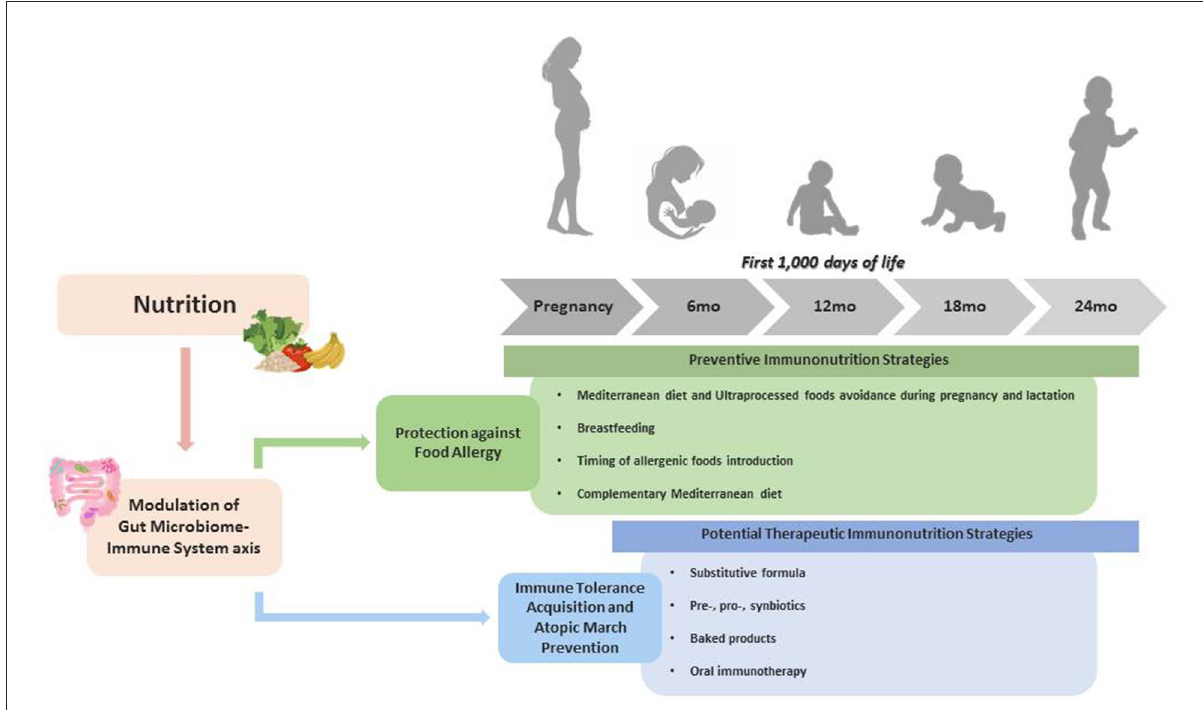
FIGURE2 Through a positive modulation of GM-Immune System axis, nutritional factors are able to prevent and potentially treat